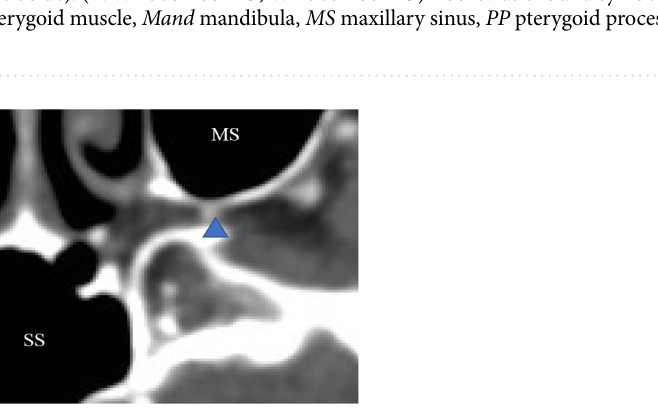
Figure 3. Relationship between the largest artery and the posterior wall of the maxillary sinus. (WW 1300 ± 80 HU; WL 500 ± 80 HU). HU Hounsfield unit, MS maxillary sinus, SS sphenoidal sinus; arrowhead: the examined artery.